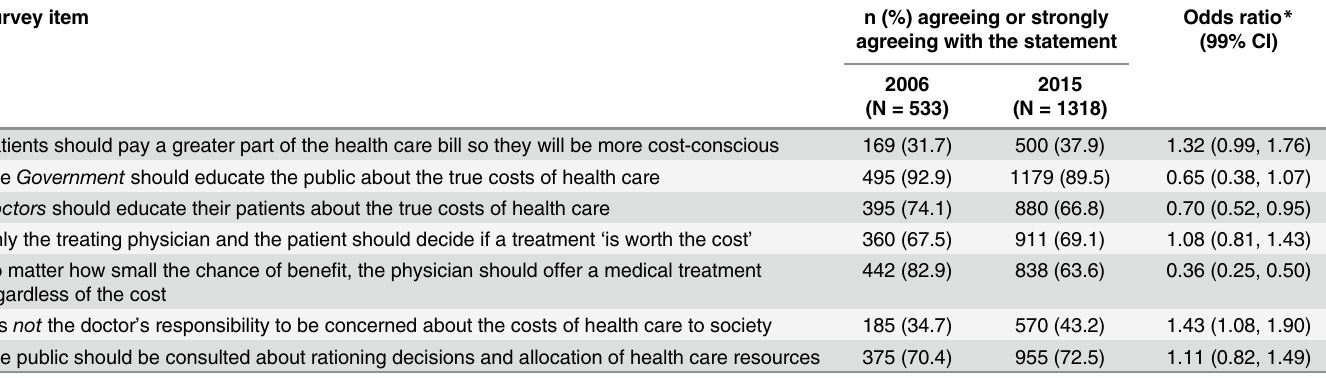
Table 3. Attitudes towards health care costs.